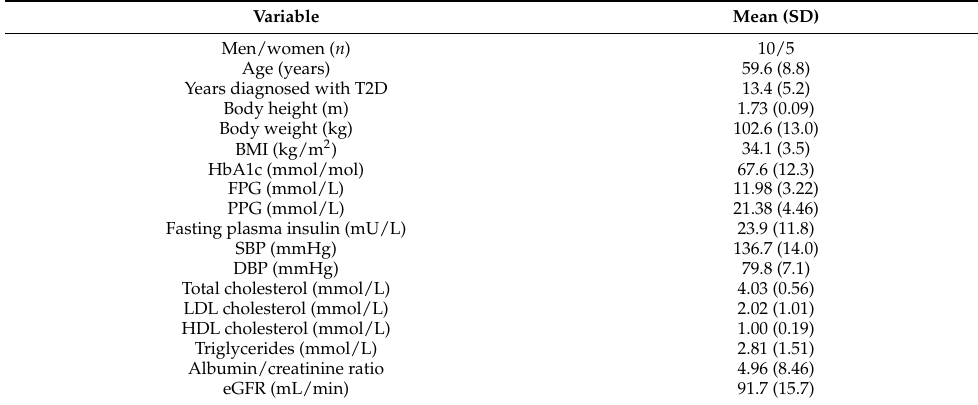
Table 2. Baseline